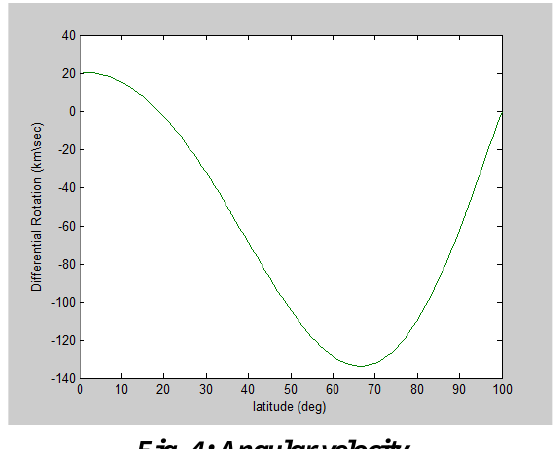
Fig. 4: Angular velocity distributionon sun surface.